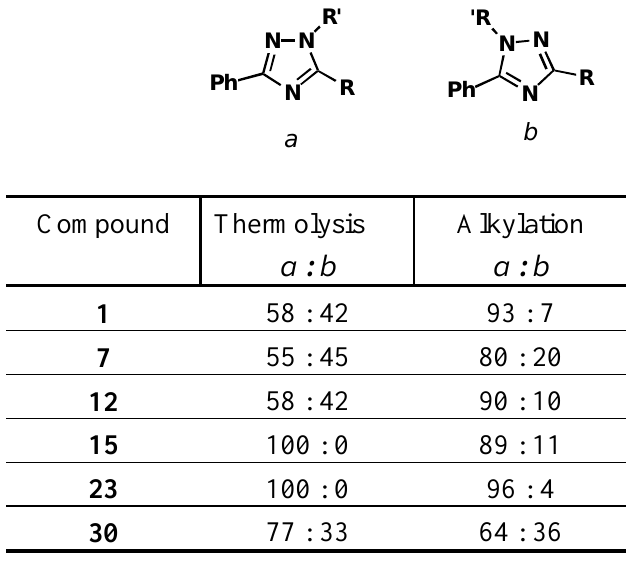
Regioselectivities for thermolysis of the neat allyl substituted triazoles at 320 o C and for alkylation of the 1 H